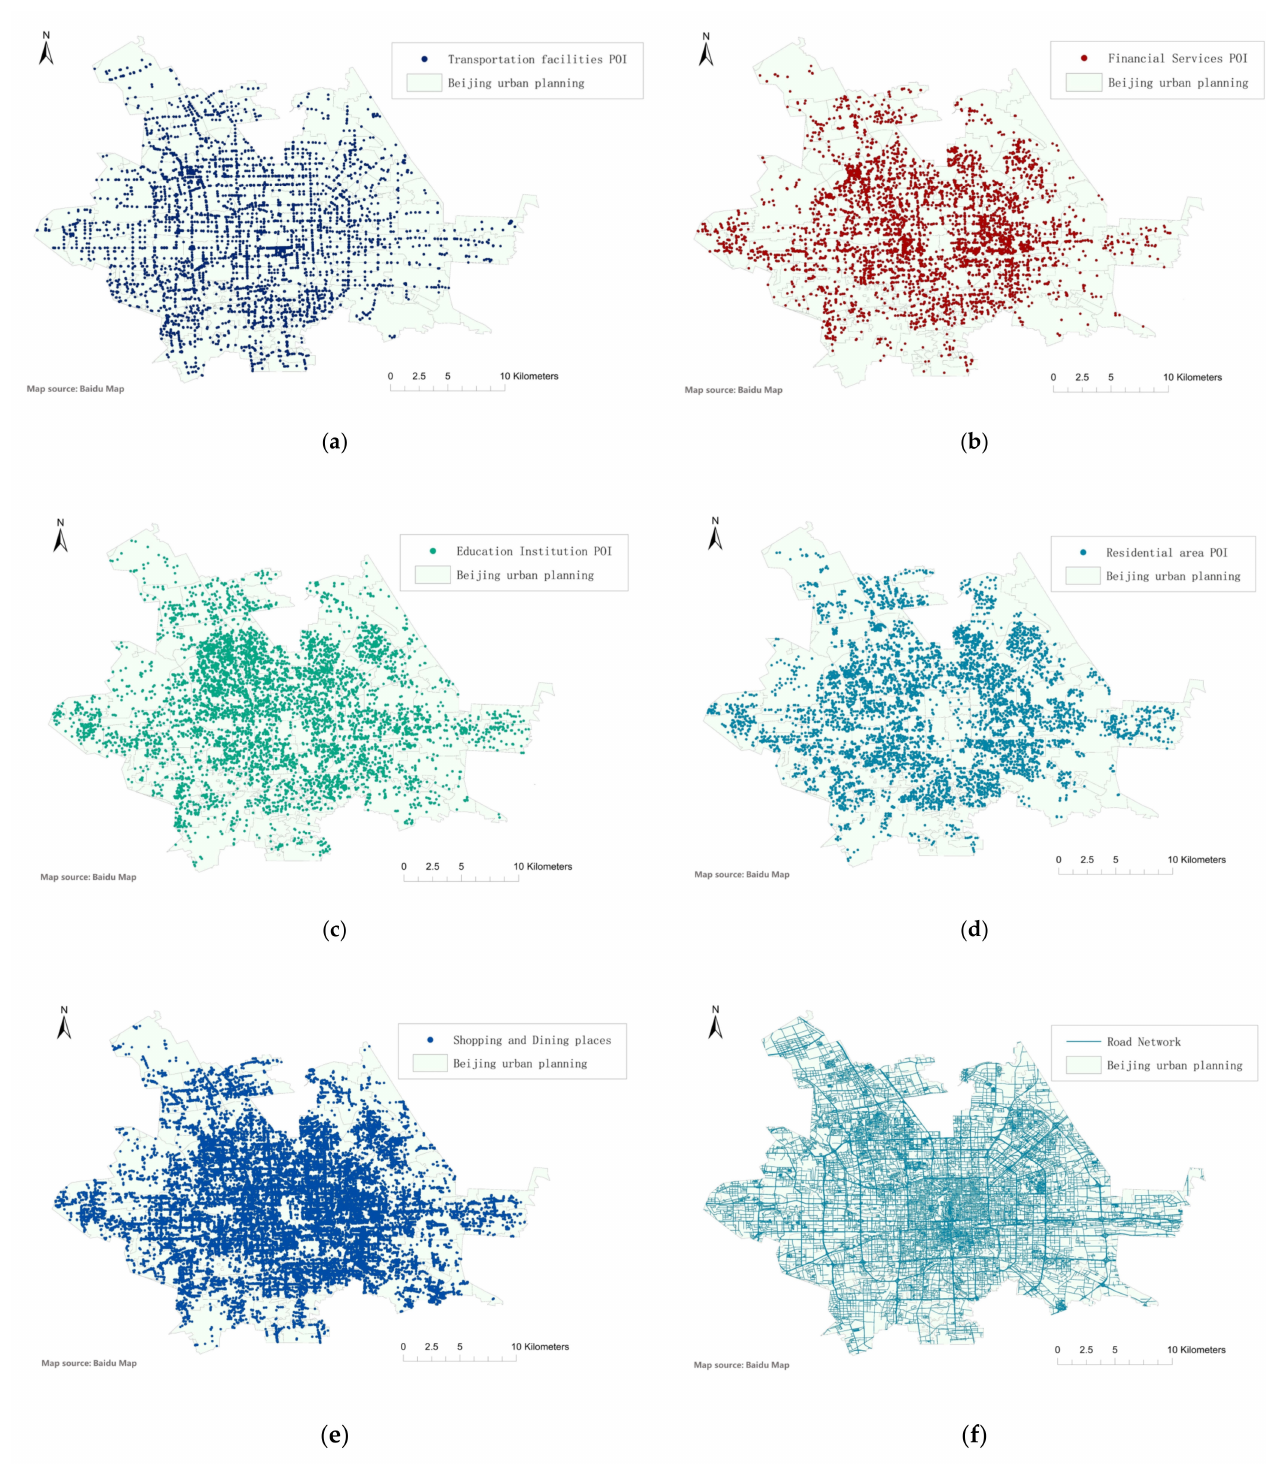
Figure 3. Spatial distribution of data in the research area: ( a ) POI of transportation facilities; ( b ) POI of financial services; ( c ) POI of education institution; ( d ) POI of residential area; ( e ) POI of shopping and dining places; ( f ) Road network in Urban Six Districts of